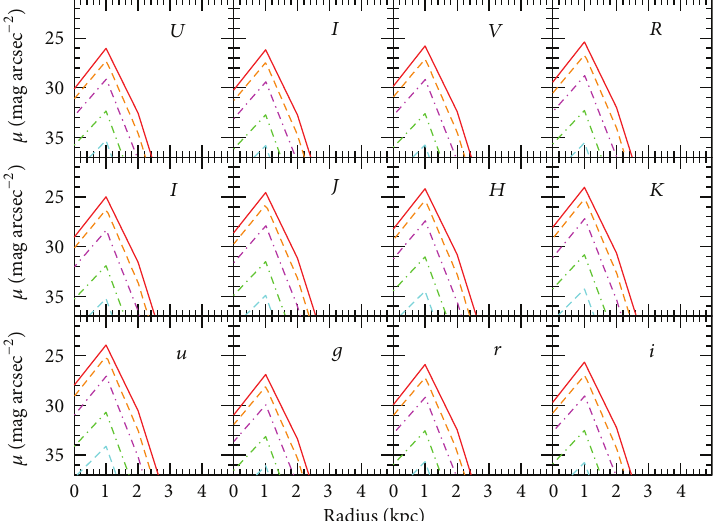
Figure 14: Evolution of surface brightness profiles for Johnson ( 𝑈 , 𝐵 , 𝑉 , 𝑅 , 𝐼 , 𝐽 , 𝐻 , and 𝐾 ) and SDSS/SLOAN ( 𝑢 magnitudes radial distributions for the least massive galaxy of Table 1 with 𝑉 max = 48 km s −1